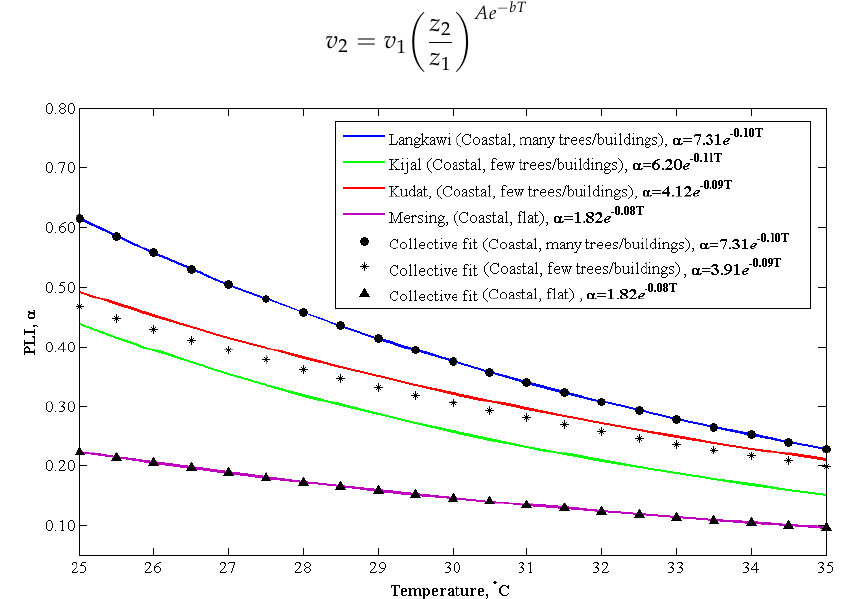
Figure 7. The exponential fit of hourly PLI versus hourly surface